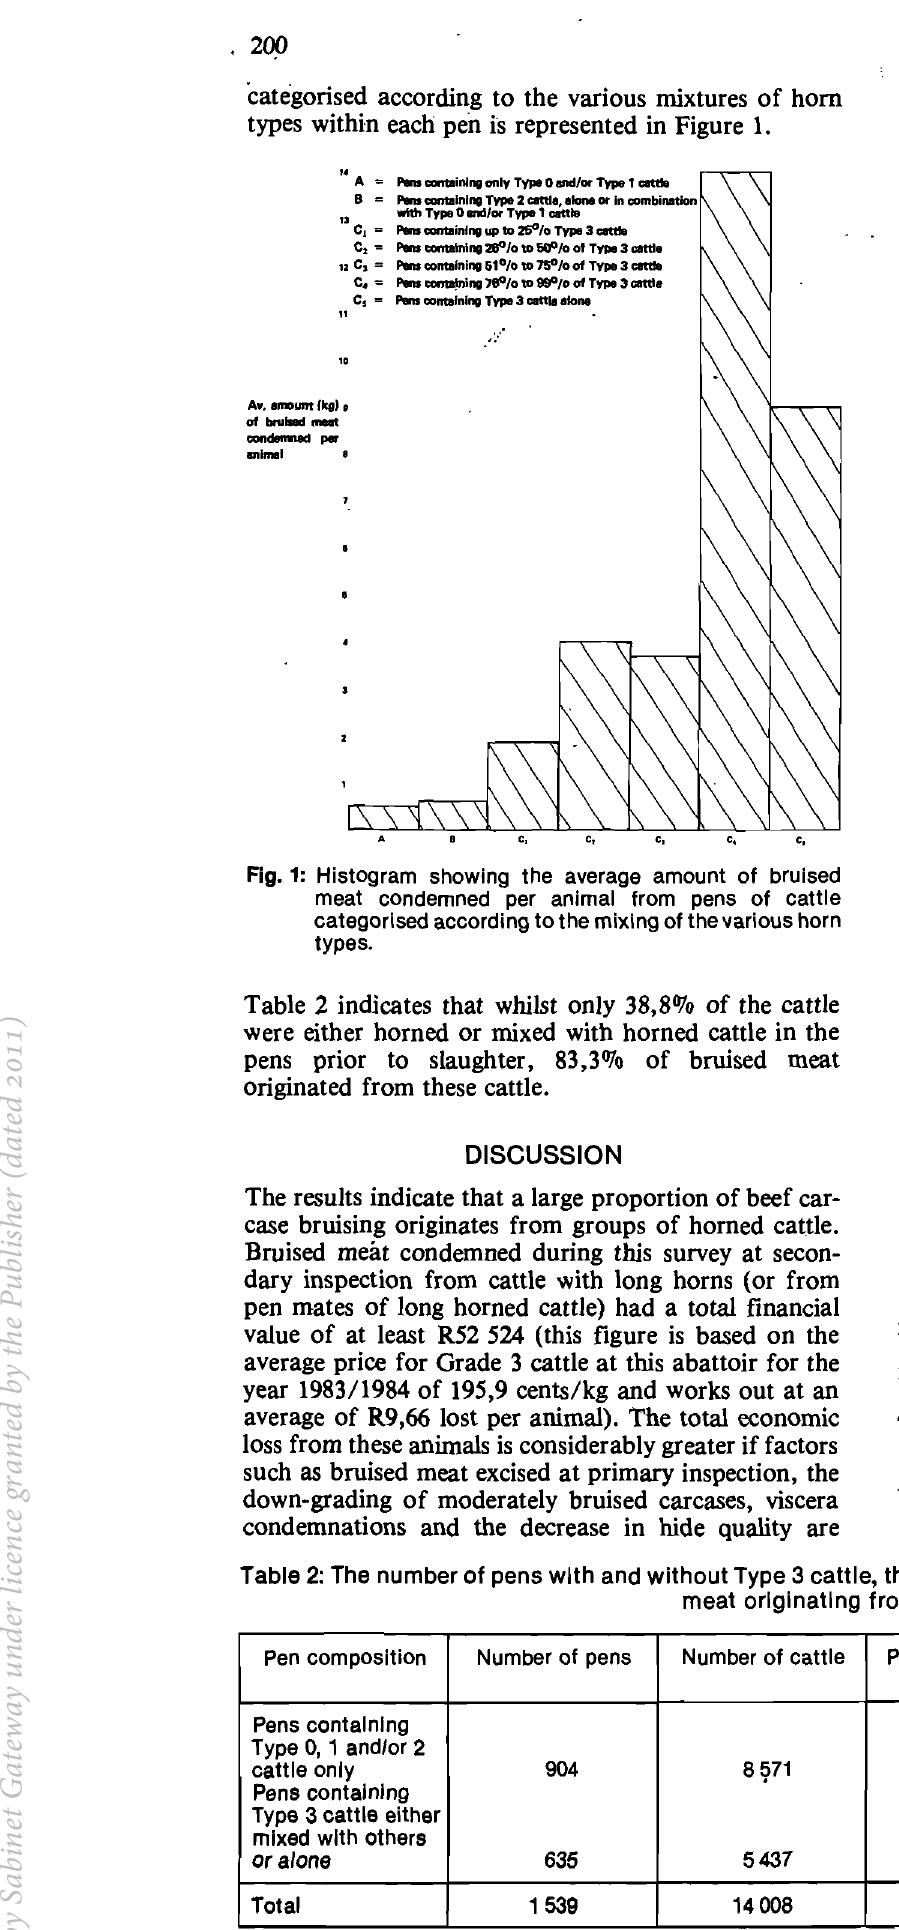
a G t e n b i a S y b d e c u d o r p e R